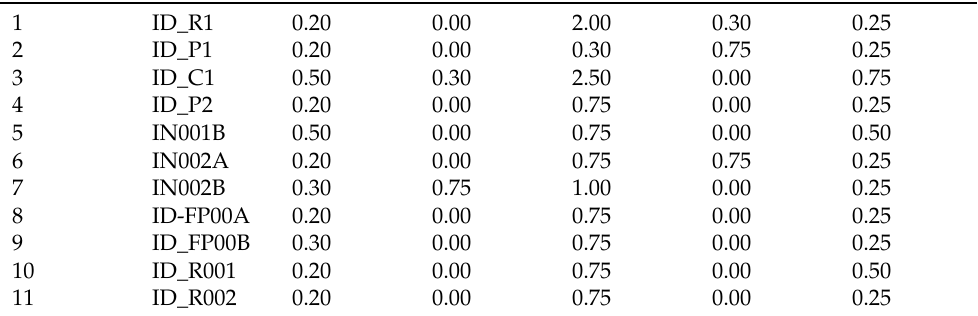
Table 12. Subtasks time of product A of the Polymer plant, structuring seven columns: Task number, Unit_ID, Preparation time, Load time, Operation time, Unload time, and Cleaning time.